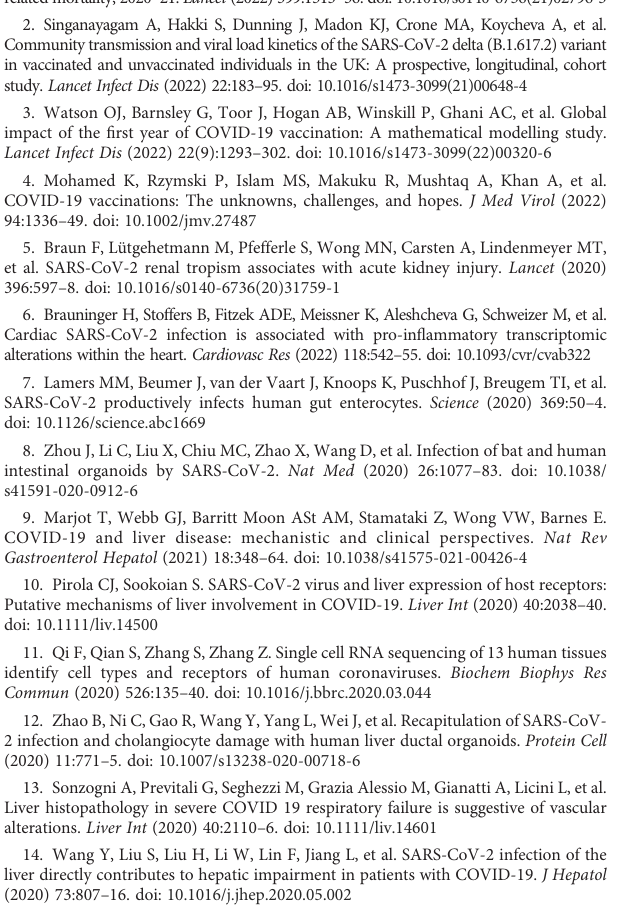
GO enrichment analysis of hepatocytes and immune cells with increased TNFA -associated target genes. (A) GO enrichment analysis in hepatocytes with elevated expression of TNFA -associated target genes from the livers of 15SARS-CoV-2 infecteddeceasedidenti fi edusingsingle-cellsequencing. (B) GO enrichment analysis in immune cells with elevated expression of TNFA - associated target genes from the livers of 15 SARS-CoV-2 infected deceased identi fi ed using single-cell